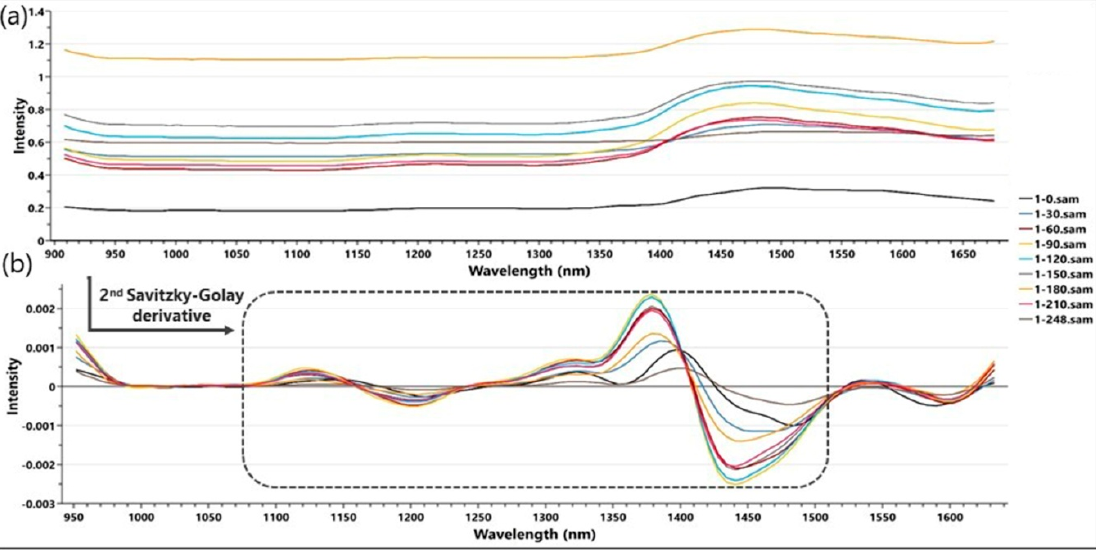
Figure 1. The raw ( a ) and 2nd derivative pre-processed ( b ) spectra registered during the fluid bed process and used for the development of the spectral prediction model.